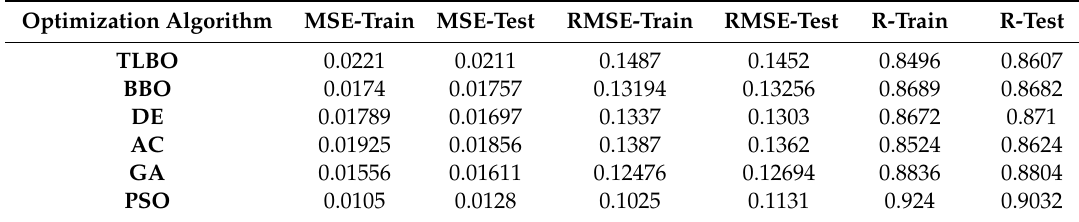
Table 4. Model evaluation criteria for six evolutionary algorithms contributing to ANFIS to predict the refining steam